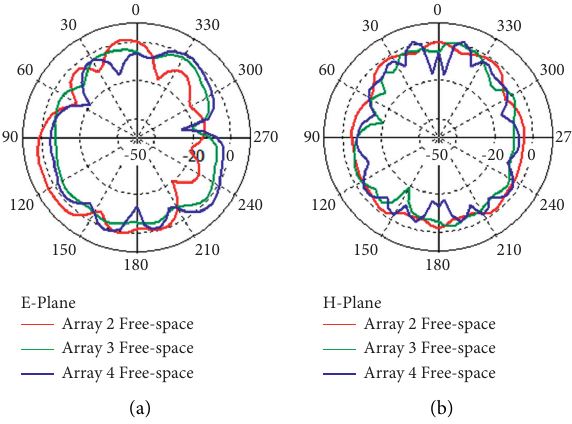
Figure 15: Radiation pattern comparison of Array 2, Array 3, and Array 4: (a) E-plane and (b)